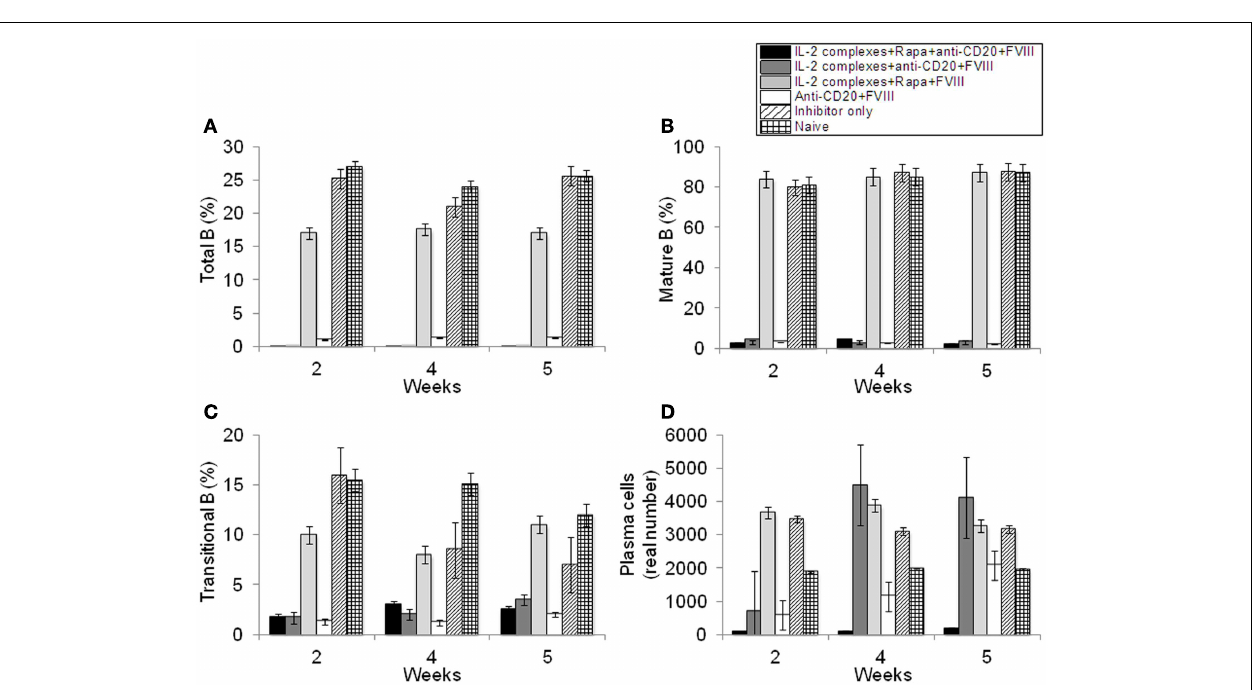
complexes + rapamycin + anti-CD20 + FVIII (black) treated mice. (A) B220 + B-cells, (B) IgM + IgD hi B-cells, (C) transitional B-cells, and (D) plasma cells were stained and analyzed by flow cytometry during the treatment period (week 2, 4, and 5). Data shown are cell percentages (A–C) and real numbers (D) of the B-cell populations. Data shown is representative of two independent experiments.